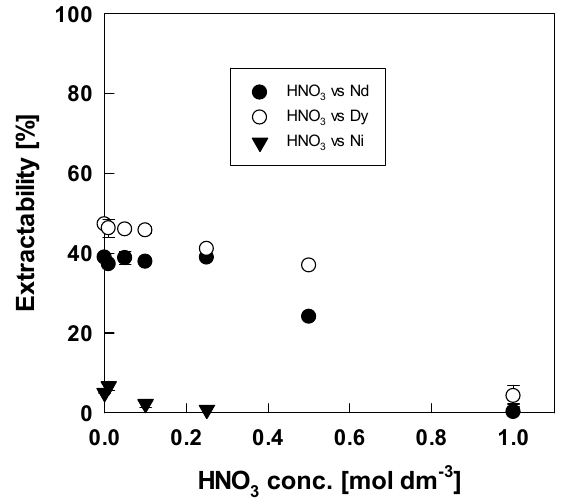
Figure 2. E ff ect of HNO 3 concentration on metal Figure 2. Effect of HNO 3 concentration on metal extractability.